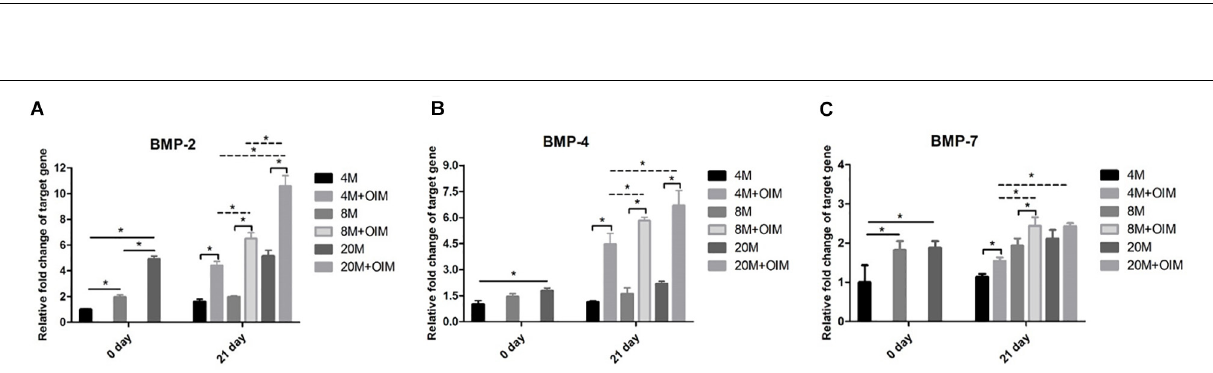
Frontiers in Cell and Developmental Biology |